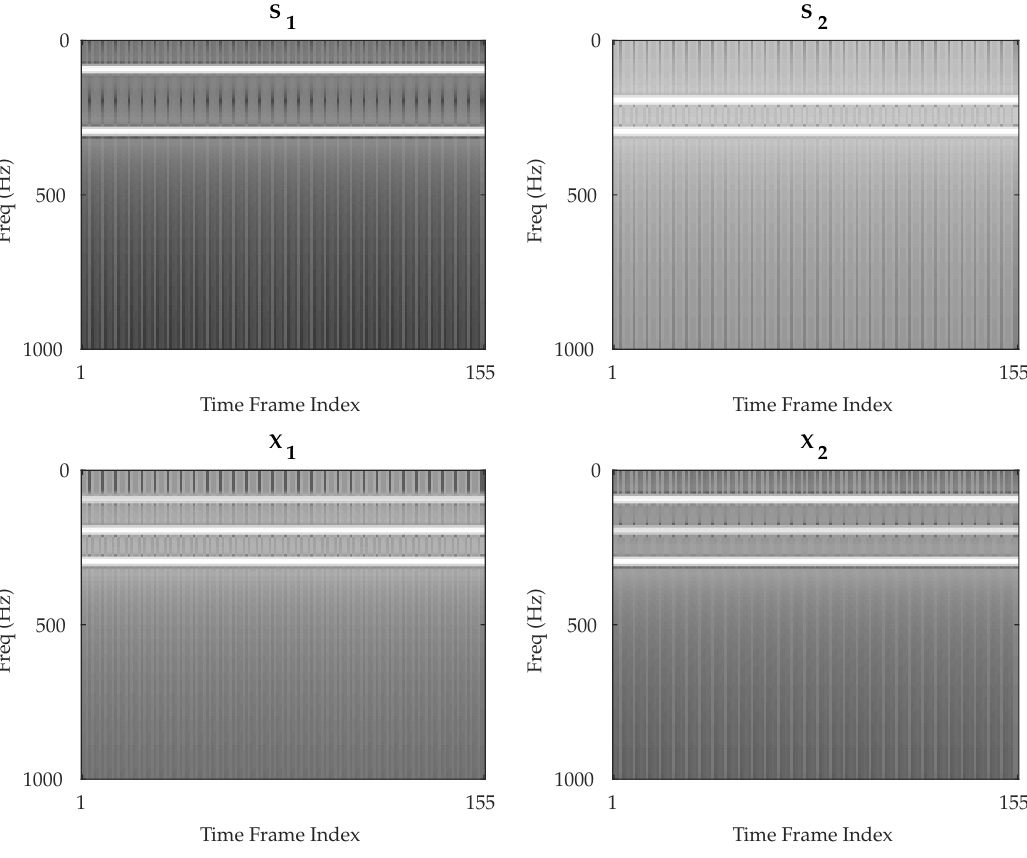
Figure 2. The magnitude spectra of the source signals, s 1 and s 2 , and mixtures, x 1 and x 2 , are illustrated for 155 analysis windows and over the frequency range 0